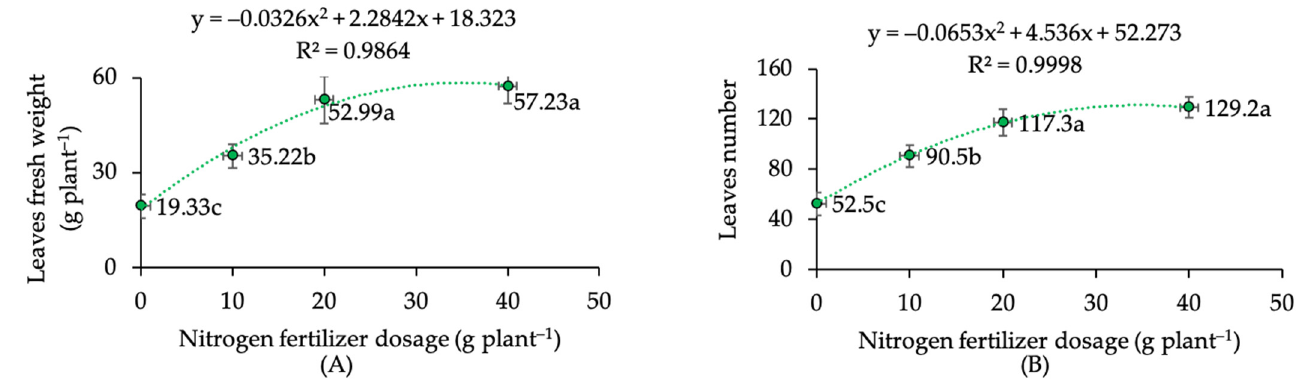
Figure 3. Regression curve of kaffir lime ( A ) fresh weight of leaves and ( B ) leaf numbers under different nitrogen-fertilizer dosages. Note: mean values followed by the same letter within the same curve are not significantly different based on DMRT at α 0.05.